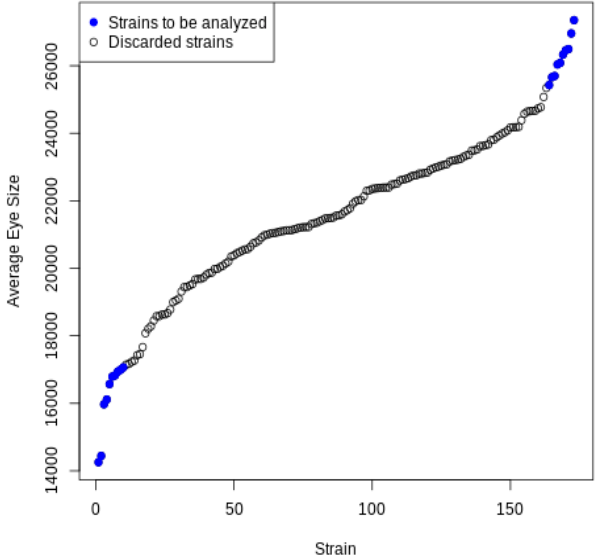
Figure 2. Average eye sizes of all strains.